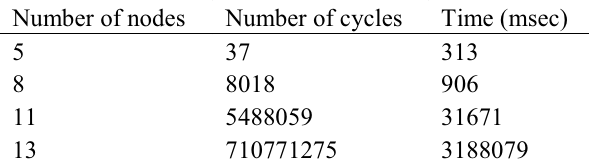
Table 1. Exact algorithm execution time.